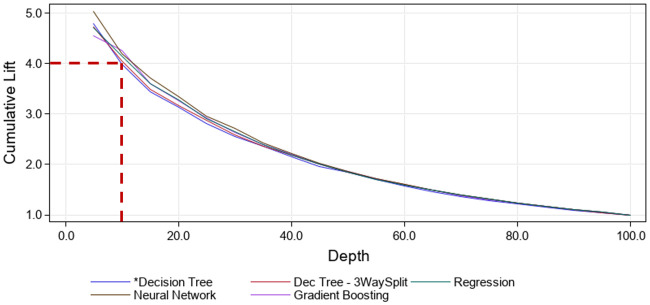
The cumulative lift for the entry model.